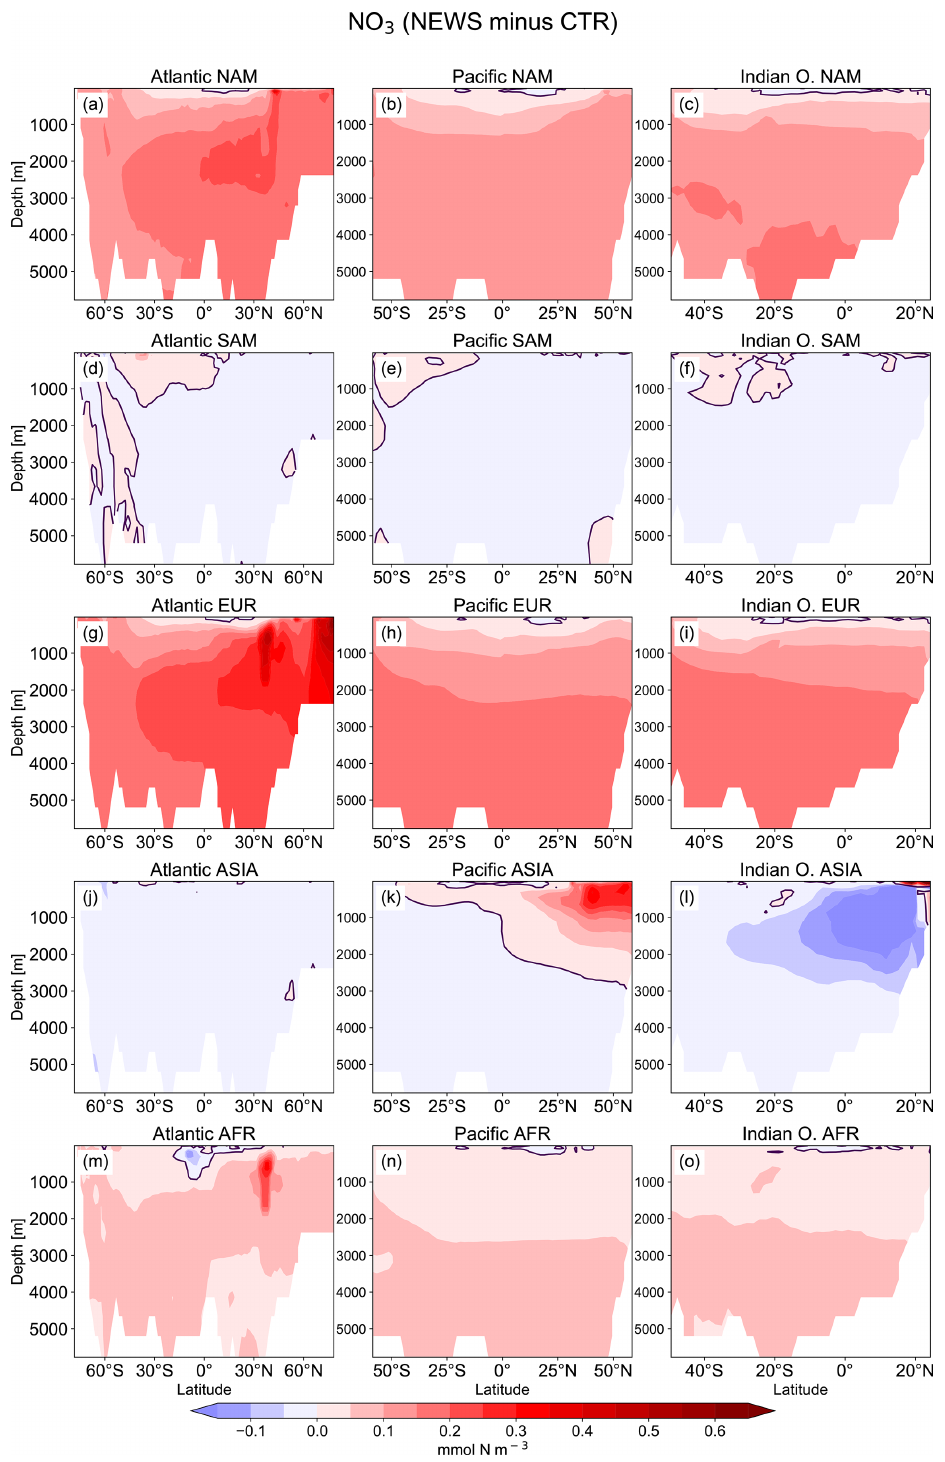
Figure 13. Difference in the zonal mean concentrations of NO 3 in the main ocean basins (Atlantic Ocean, Pacific Ocean, and Indian Ocean) between regional NEWS and the control simulation (CTR). The regional simulations show export from rivers in North America (a–c) , South America (d–f) , Europe and Russia (g–i) , Asia (j–l) , and Africa (m–o) . The violet line indicates the 0.0mmolN contour line. Maximum differences can be found in the Indian Ocean ASIA, with minimum values at − 0.9mmolNm − 3 and maximum values at 2.5mmolNm − 3